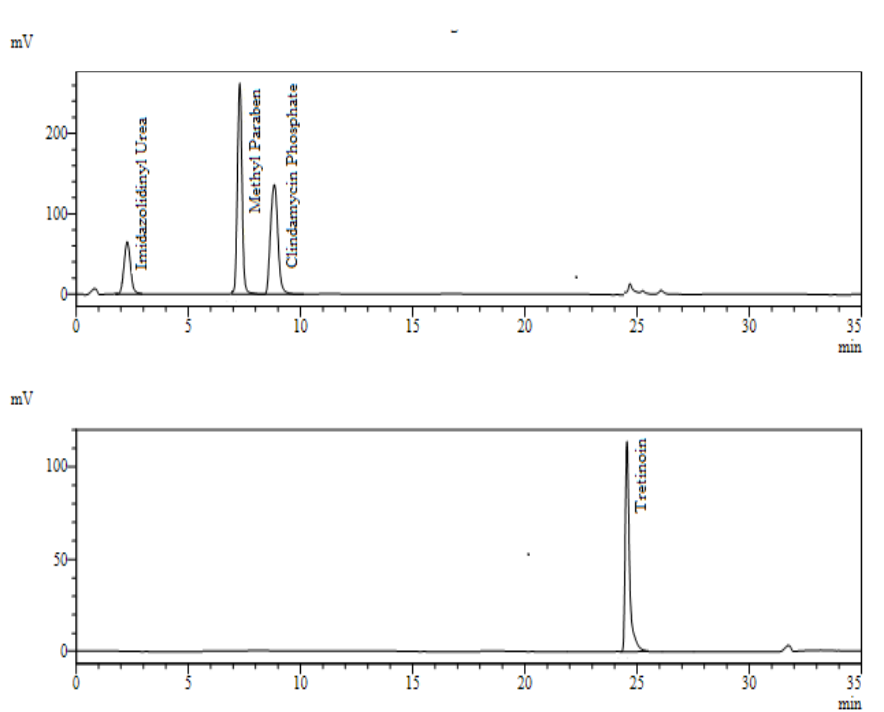
Figure 2. HPLC chromatogram of standard solution. Peaks: imidazolidinyl urea, t R ∼ 2.2 min; methyl paraben, t R ∼ 7.3 min; clindamycin phosphate, t R ∼ 8.9 min; tretinoin, t R ∼ 24.8 min.